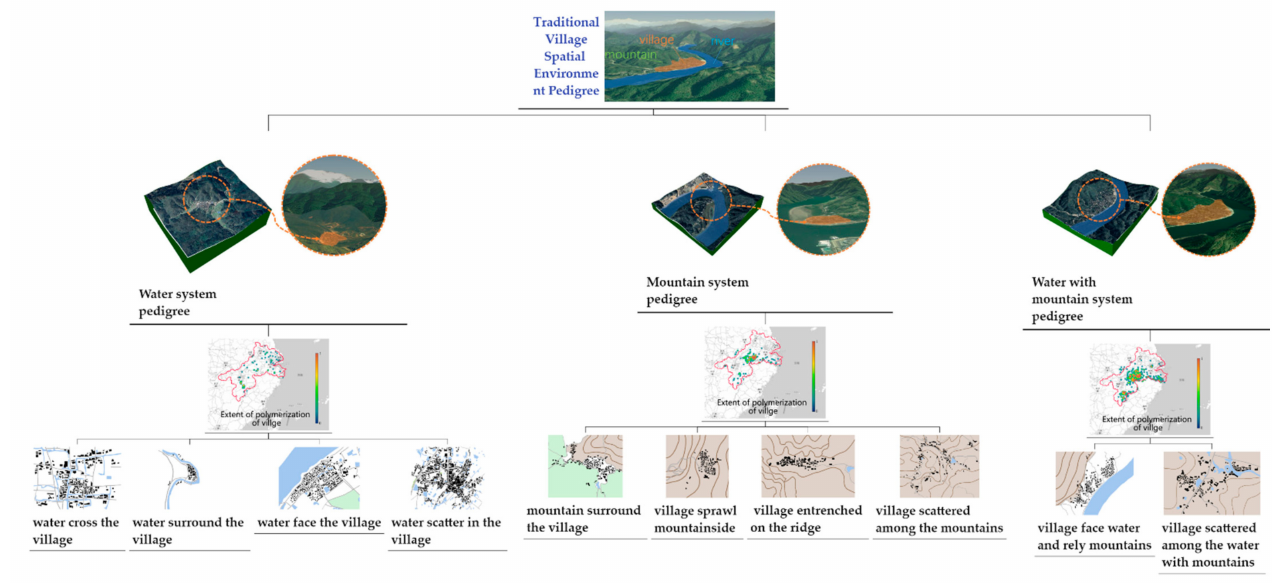
Figure 7. Traditional village spatial environment pedigree structure: edited by